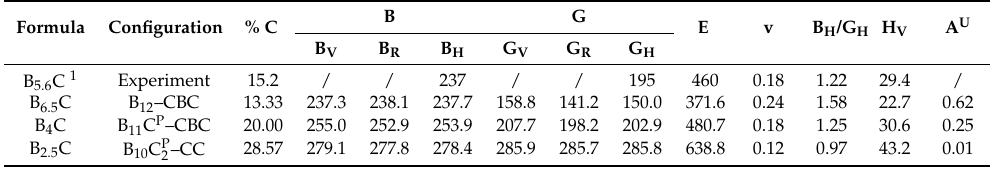
Table 3. The bulk modulus B (GPa), shear modulus G (GPa), Young’s modulus E (GPa), Poisson